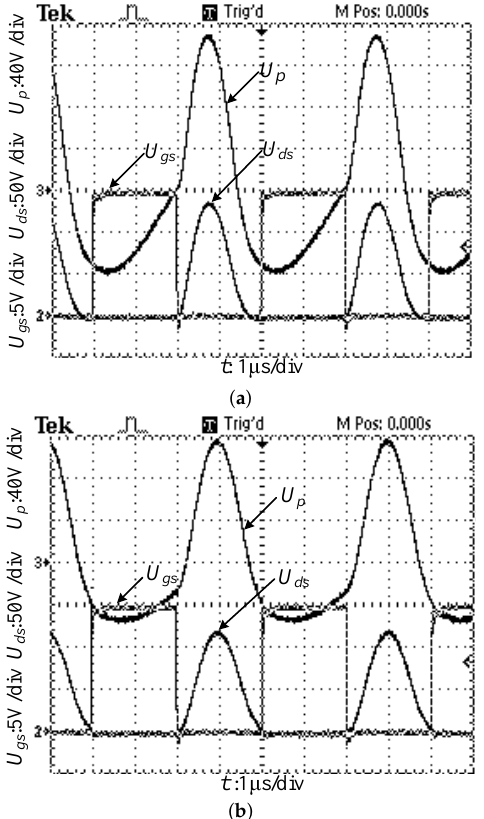
Figure 10. Experimental waveforms under different loads: ( a ) R L = 100 Ω ; ( b ) R L = 600 Ω . In some experiments, transmission power and system efficiency were tested when the transfer distance was 10 mm and the system’s input voltage was 30 VDC. Transmission power was